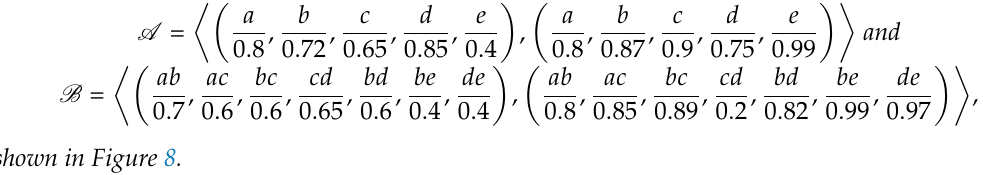
Figure 7. G = ( A , B Figure 3.5: G = ( A , B )